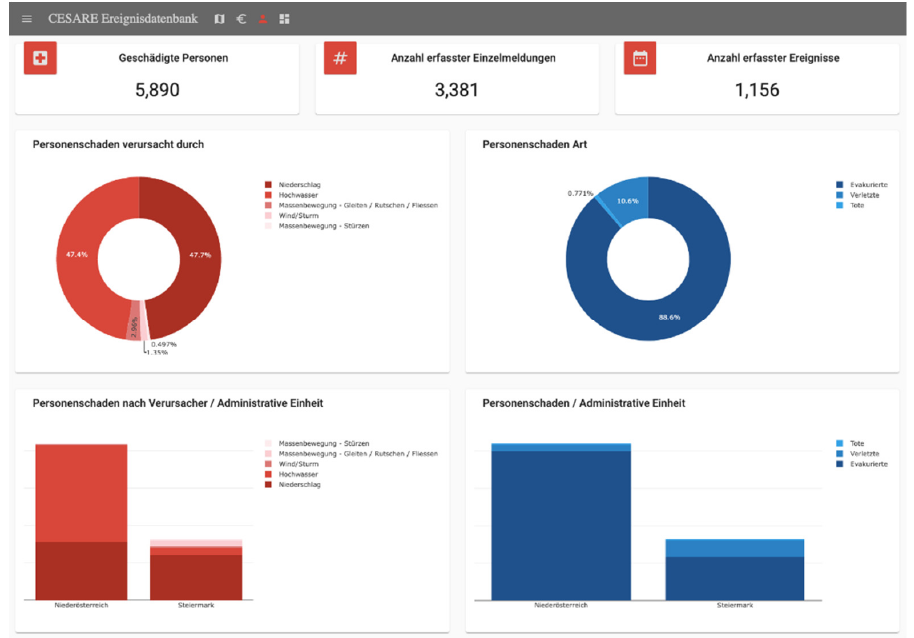
Figure 8. Snapshot of the CESARE demonstrator dashboard service for economic losses.